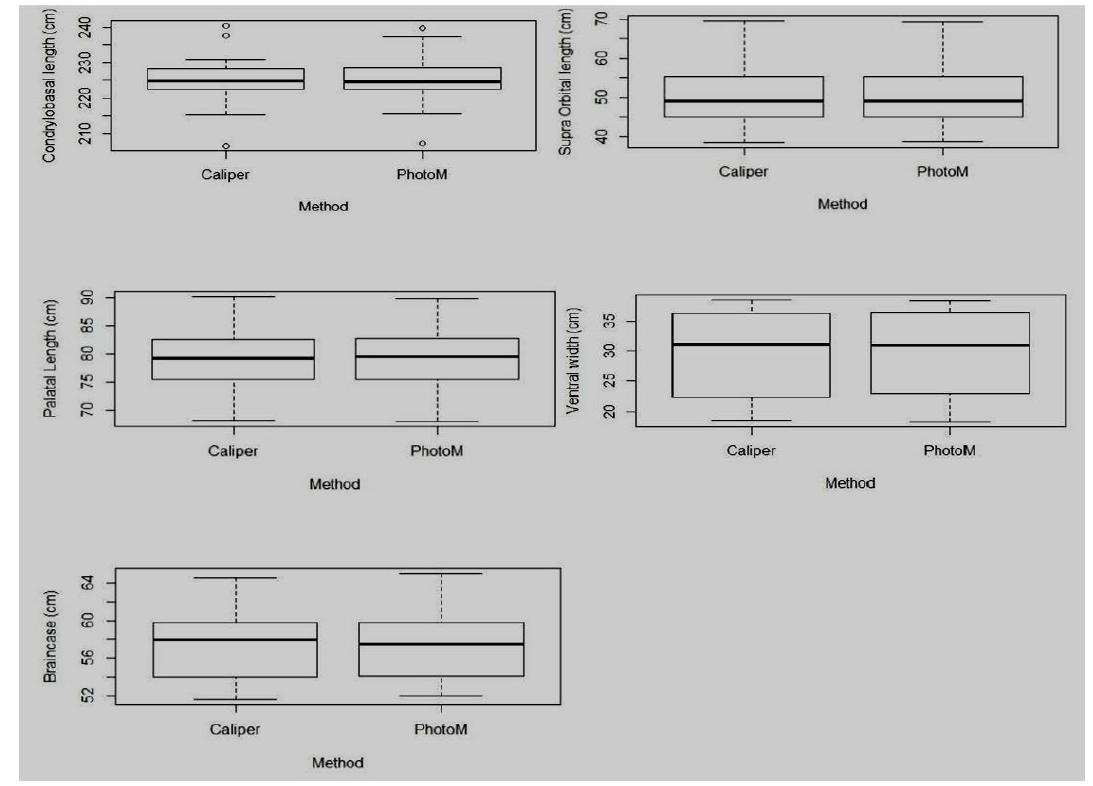
Figure 2. Similarity analysis (F test, Welch Two Sample t-test, Kruskal-Wallis rank sum test ) between PMSc® and Caliper measurements, Median, Interquartile range, and outliers of the measured variables used for the comparison of caliper and 3D PMSc® measurements.